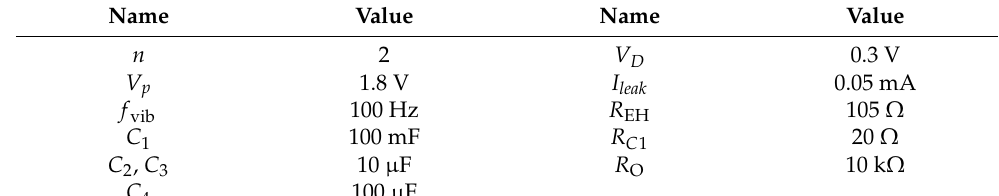
Table 1. The circuit parameters of VM mode used in the loss analysis.